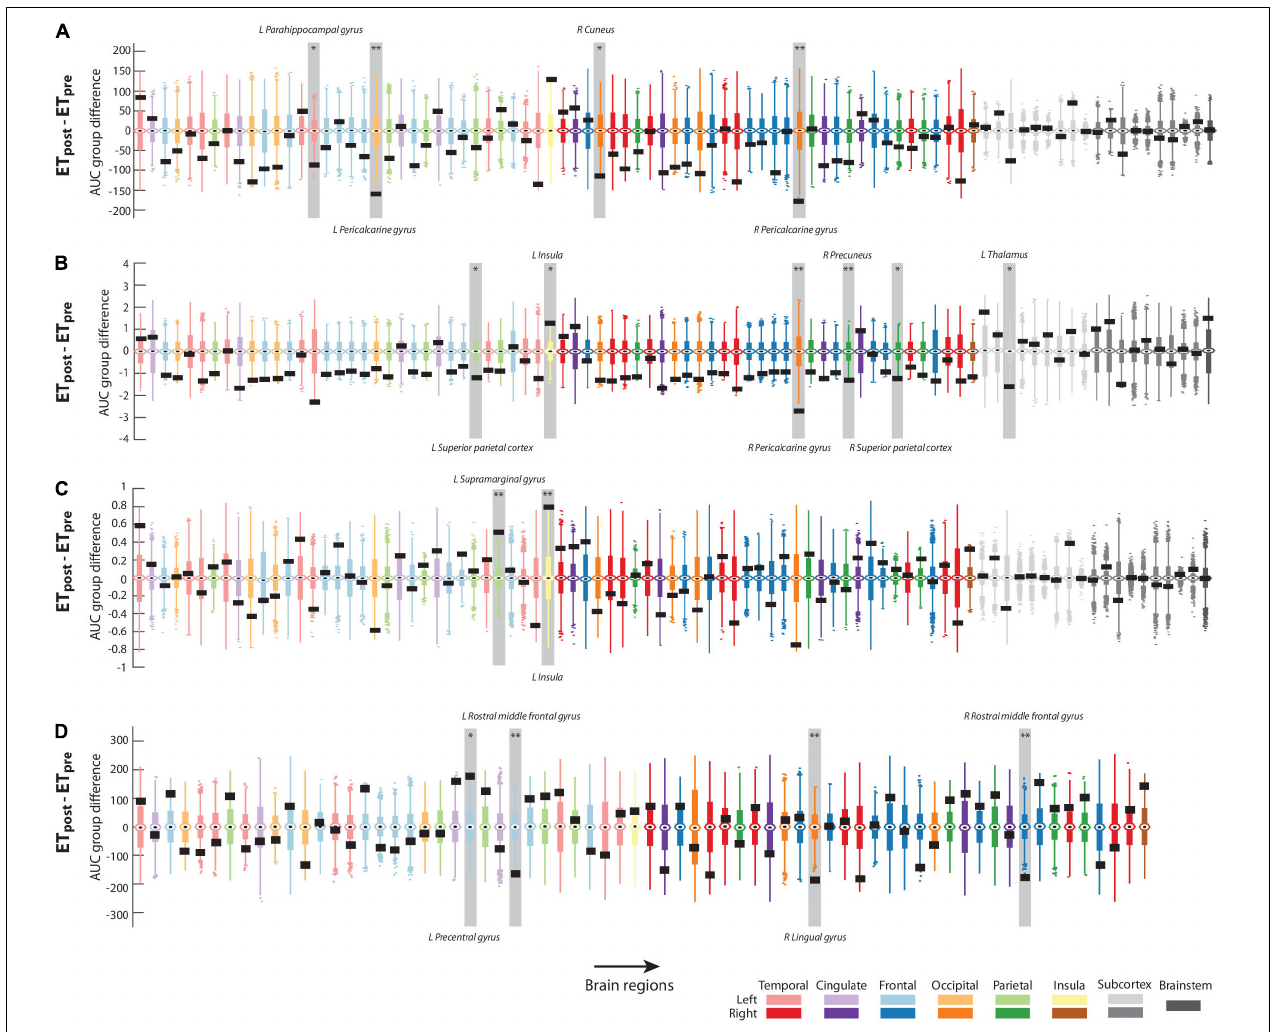
FIGURE 2 | Significant graph theoretical analysis findings. For regional degree (A) , clustering coefficient (B) , eigenvector centrality (C) , and out-degree (D) , group differences in area under the curve for the ET post – ET pre contrast in the assessment of mean curvature structural covariance (A–C) or cortical thickness/mean curvature interactions (D) . Actual values are denoted by black rectangles, and associated null distributions are reflected by box plots whose color coding matches the brain lobe at hand. The regions that reached significance in each case are highlighted by a light gray box and labeled. ∗ : p < 0.01; ∗∗ : p < 0.001.